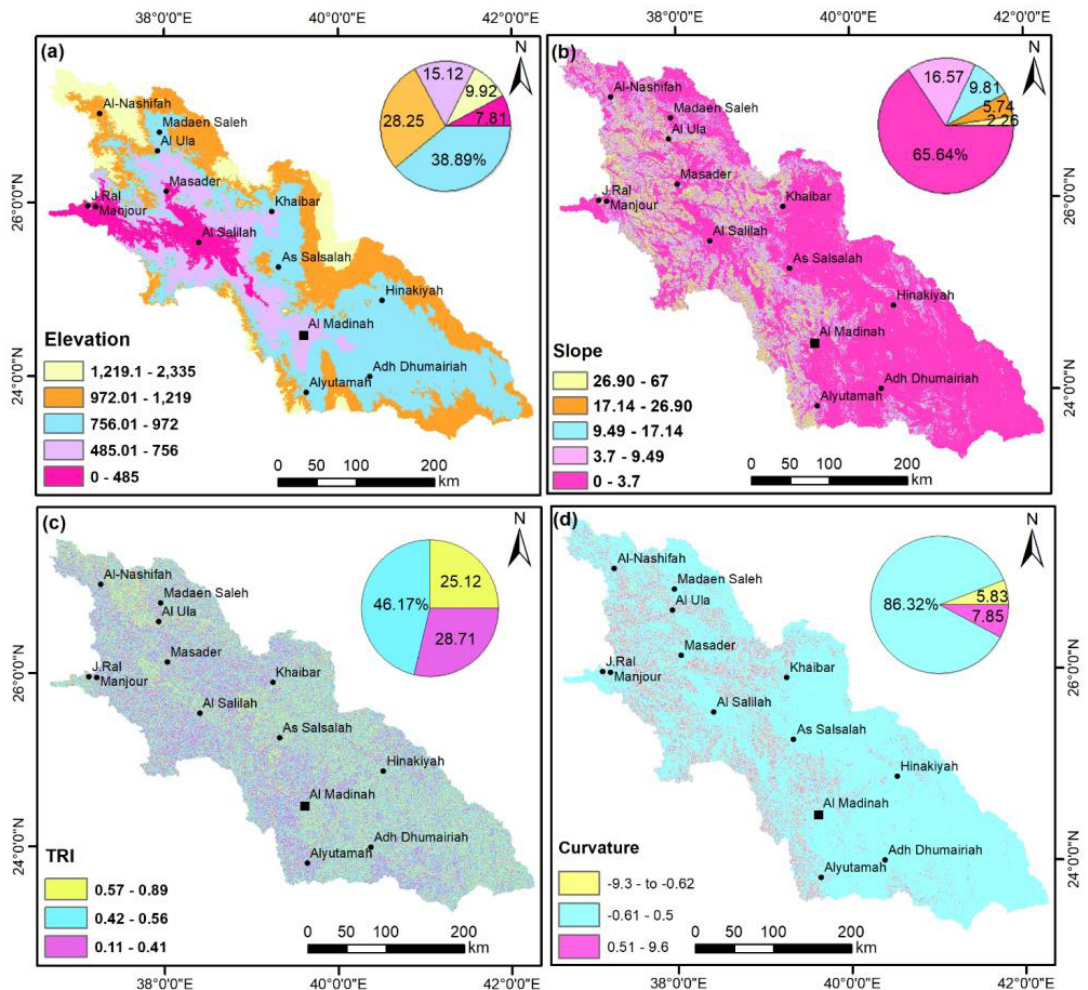
Figure 3. Topographic factors; ( a ) elevation; ( b ) slope; ( c ) TRI; ( d )